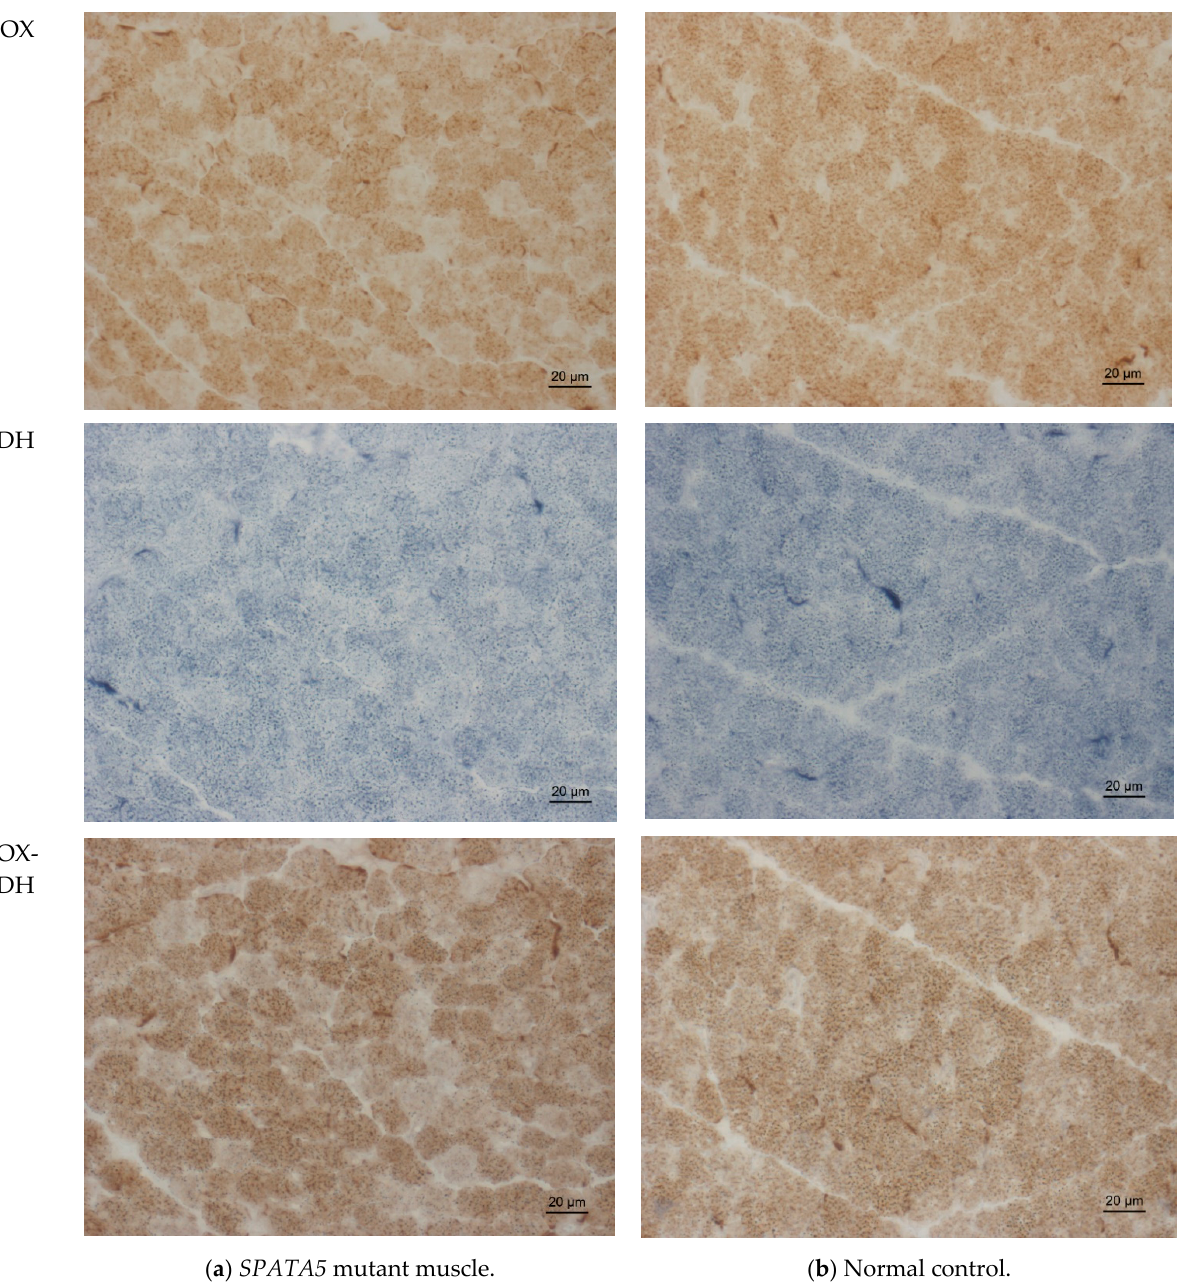
( a ) SPATA5 mutant muscle. ( b ) Normal control. Figure 3. Enzyme histochemistry in SPATA5 mutant quadriceps muscle showing slightly reduced SDH reaction and no COX-negative fibers ( a ); comparison to normal control ( b ). COX, cytochrome c oxidase; SDH, succinate dehydrogenase.